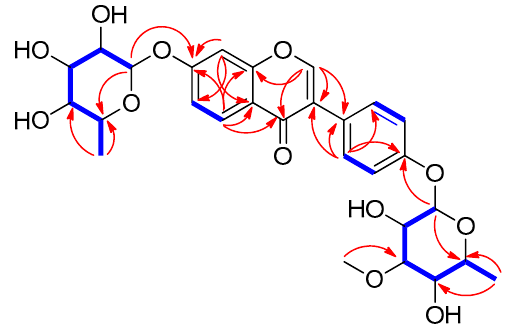
Figure 2. Key COSY/TOCSY ( ) and HMBC ( → ) correlations for compound 1 .